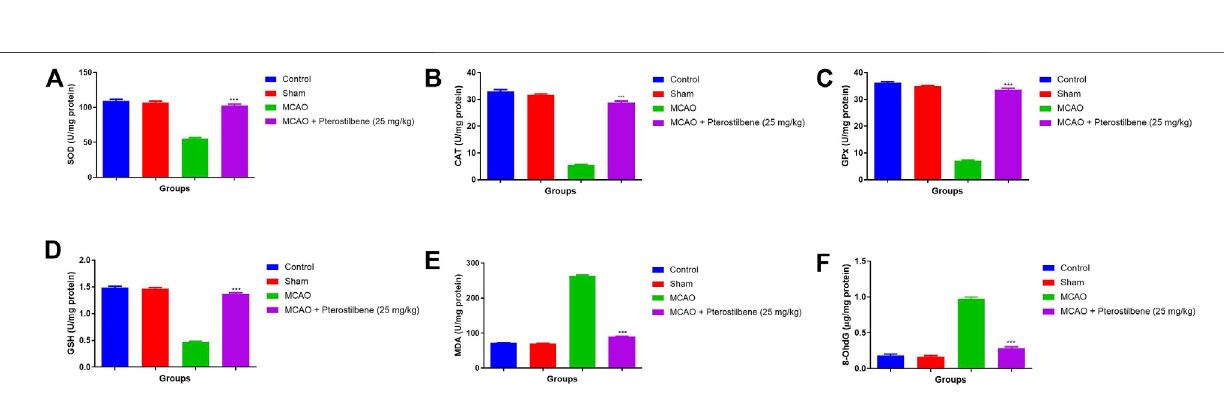
Table 1 demonstrated the effect of pterostilbene on the brain tissue histopathology. MCAO group rats demonstrated the development of cellular swelling, cellular disintegration, macrophage in fi ltration, monocyte in fi ltration and polymorphonuclear leucocyte degranulation. Pterostilbene treatment suppressed the cellular